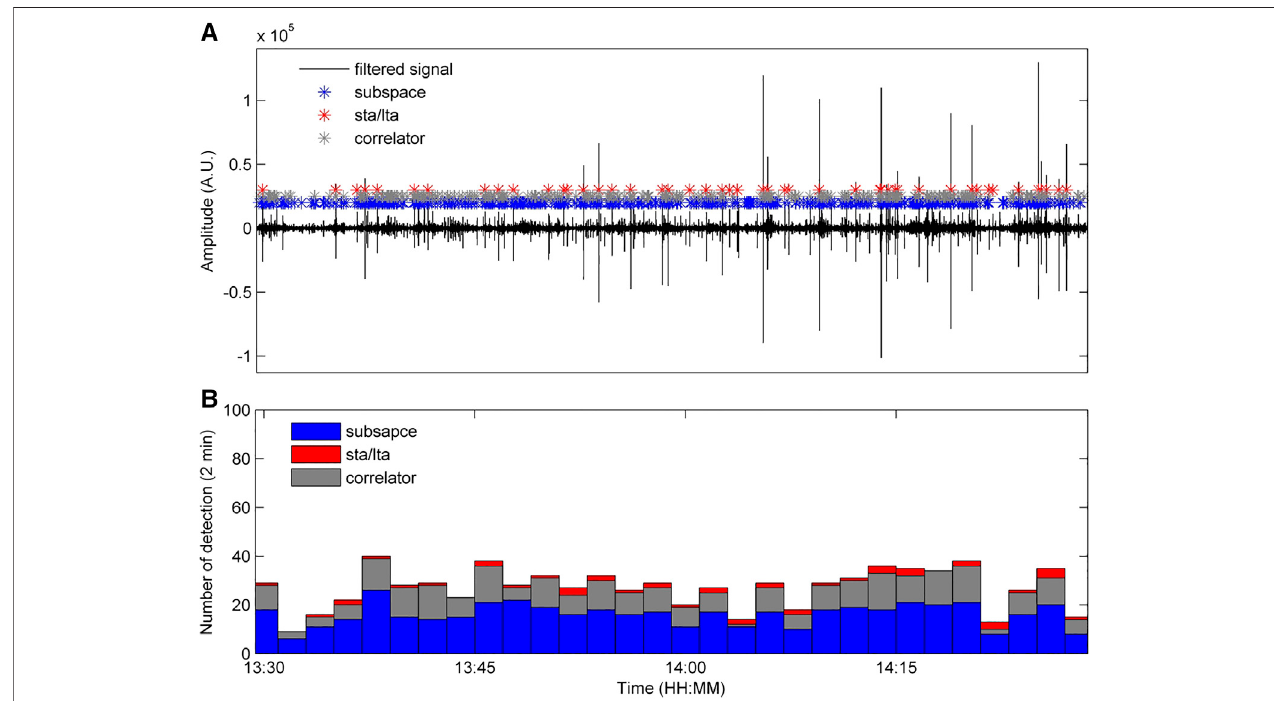
FIGURE9| SignalrecordedatEMFOstationand fi lteredintheband1-10Hzwiththeoverlappedpositionsofdetectionsobtainedin1-slongwindowbysubspace (blue asterisks), correlation (green asterisks) and STA/LTA (red asterisks) detection algorithms for 99.99 percentile and using four SVD (A) . Event occurrence rate resulting from subspace, correlation and STA/LTA detection algorithm counted in 2-min-long window (B) .